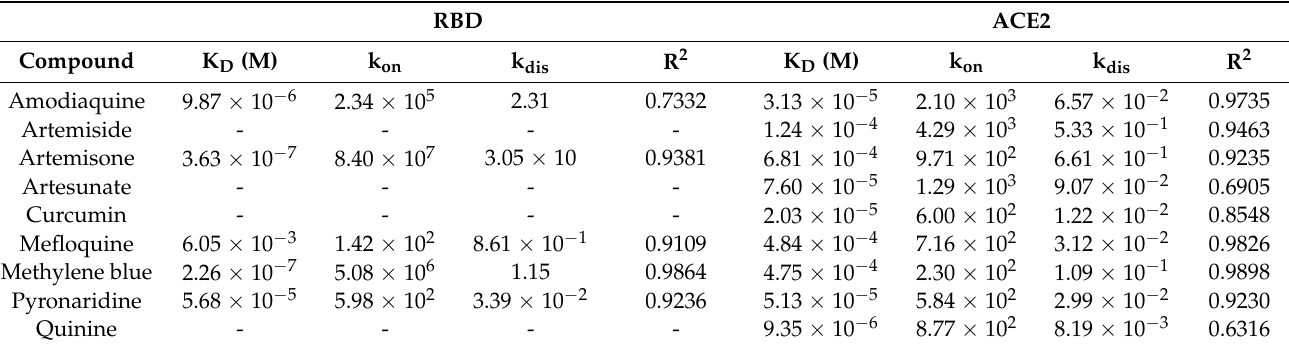
Table 1. Results of bio-layer interferometry experiments for probing the interaction of the compounds with the RBD and ACE2 in vitro. Calculated association rate (k on , 1/Ms), dissociation rate (k dis , s − 1 ) and dissociation constant (K D , M) are reported.